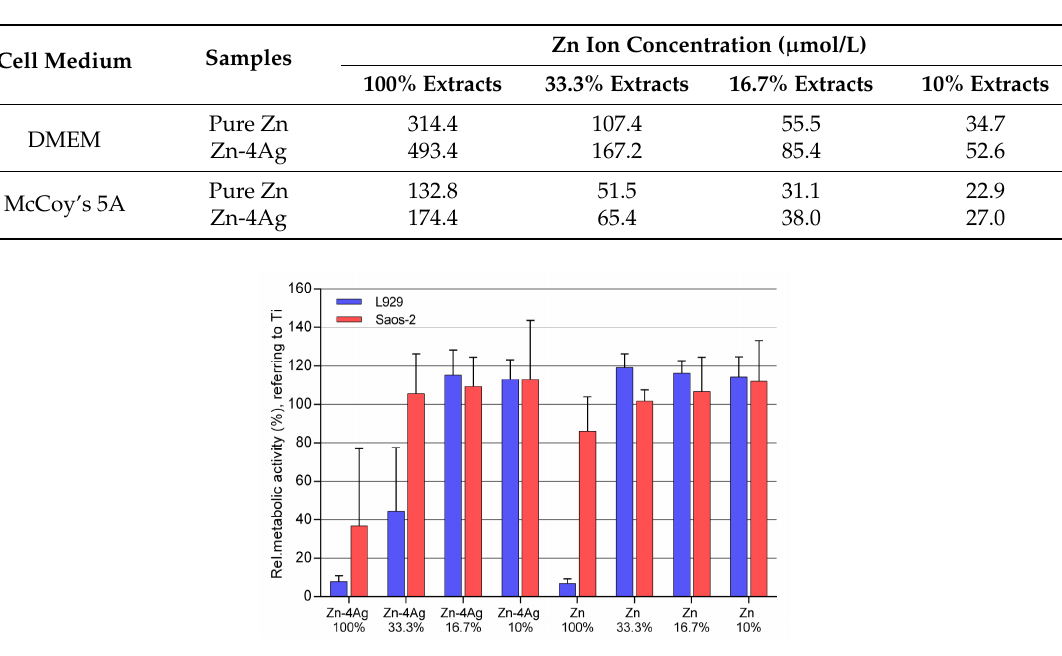
Figure 7. Effect of different concentrations of Zn-4Ag alloy and pure Zn extracts on the cell metabolic activity of L929 and Saos-2 determined by XTT assay. Ti-6Al-4V alloy was used as the negative control and was set to 100%. Means of three independent experiments are shown with respective standard deviations.